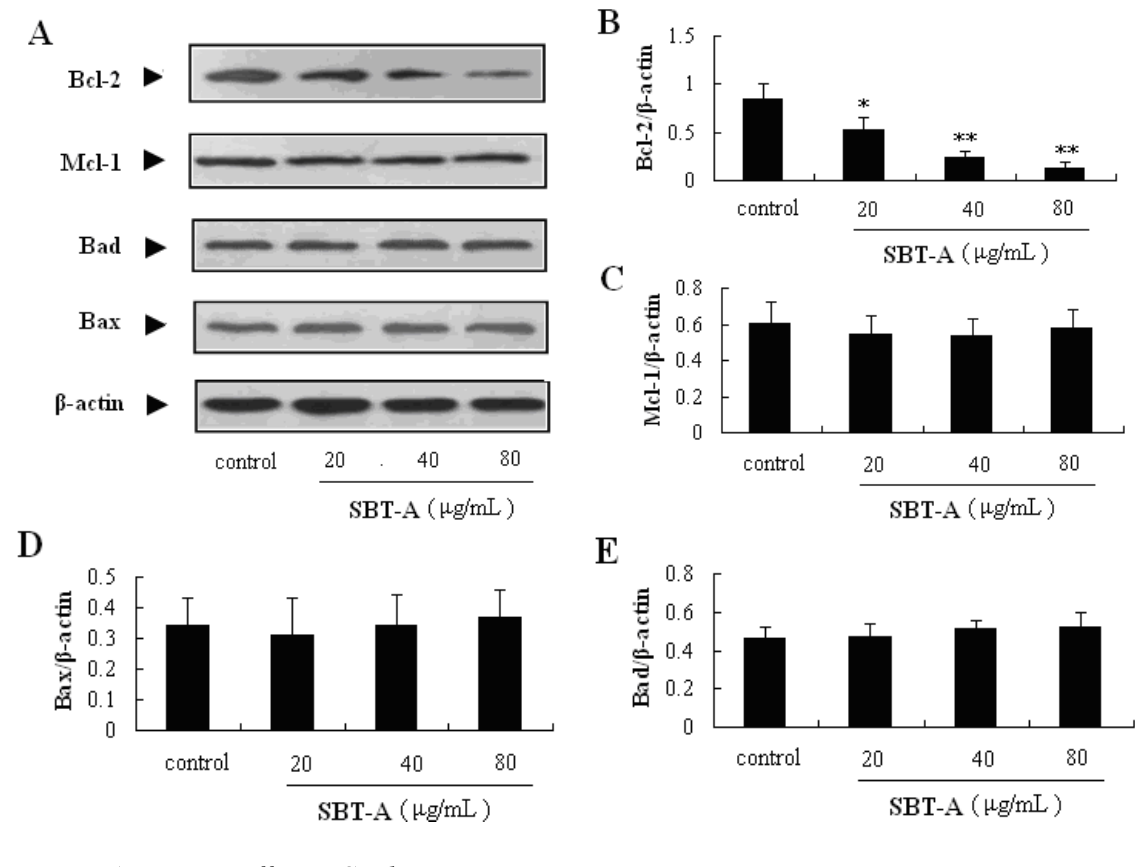
Figure 6. Effects of SBT-A on expressions of Bcl-2 family proteins on A549 cells. A549 cells were treated with low to high concentrations of SBT-A (20, 40, and 80 μ g/mL) for 48 h, then the different proteins levels were measured by western blotting, respectively. The data are represented as mean ± S.D ( n = 4). * p < 0.05 and ** p < 0.01 vs.